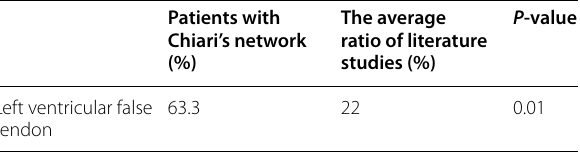
Table 4 Comparison of the left ventricular false tendon ratio in literature and patients with Chiari’s